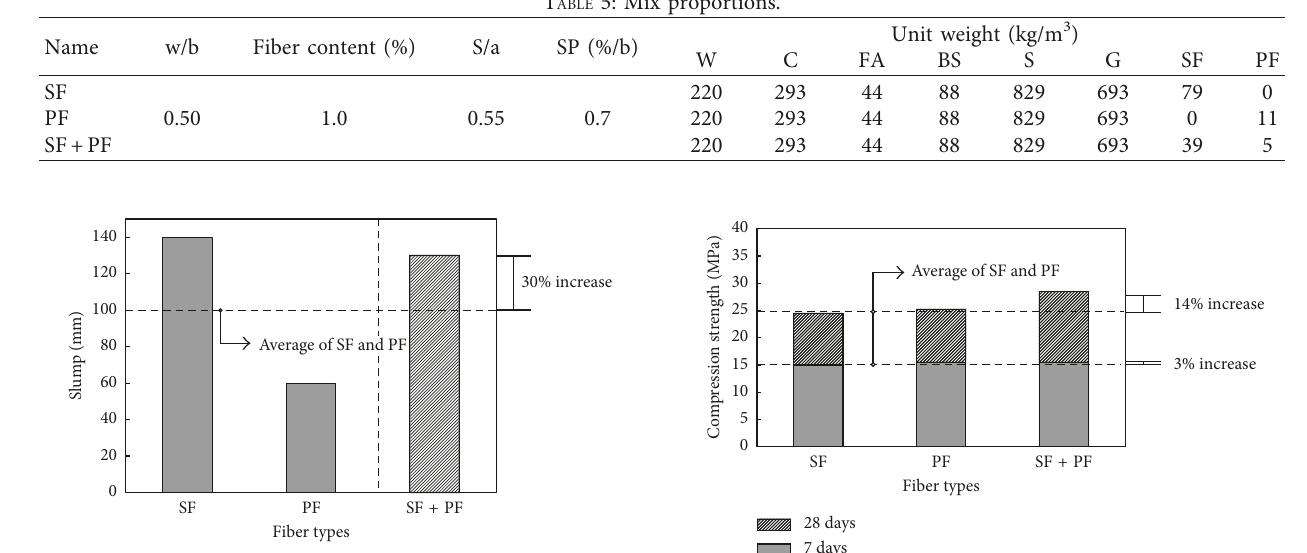
Figure 2: Influence of fiber combination on slump of concrete mixtures (the dotted line expresses the average value of SF and